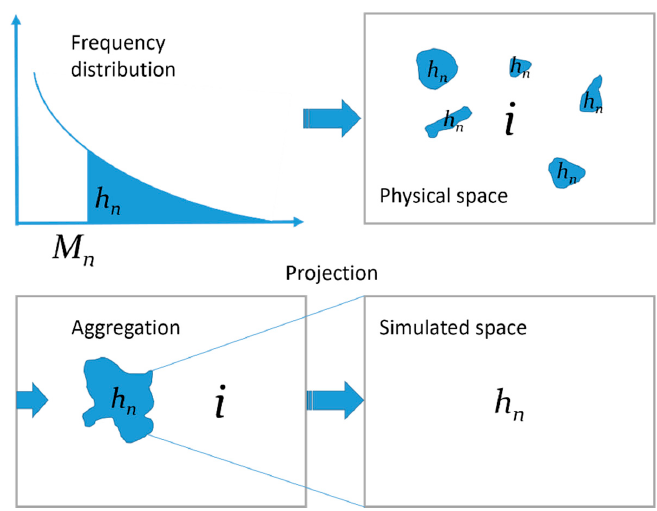
Figure 1. An illustration of the introduced topological transformation of the new method: from n-th partition after the mean ( M n ) and creation of head groups ( h n ), to their (virtual) aggregation in the physical space and their projection to a simulated space.